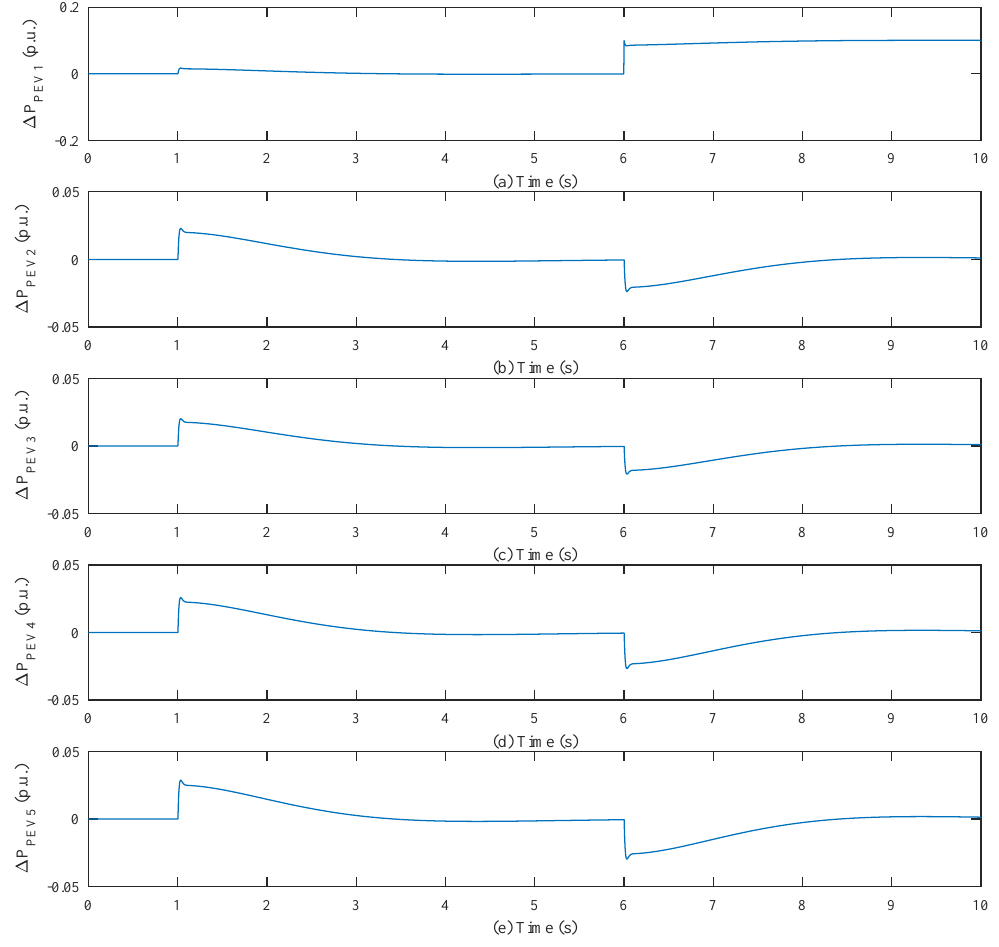
Figure 12. Transient power output of PEV. ( a ) Dynamic response of PEV 1 ; ( b ) dynamic response of PEV 2 ; ( c ) dynamic response of PEV 3 ; ( d ) dynamic response of PEV 4 ; ( e ) dynamic response of PEV 5 .